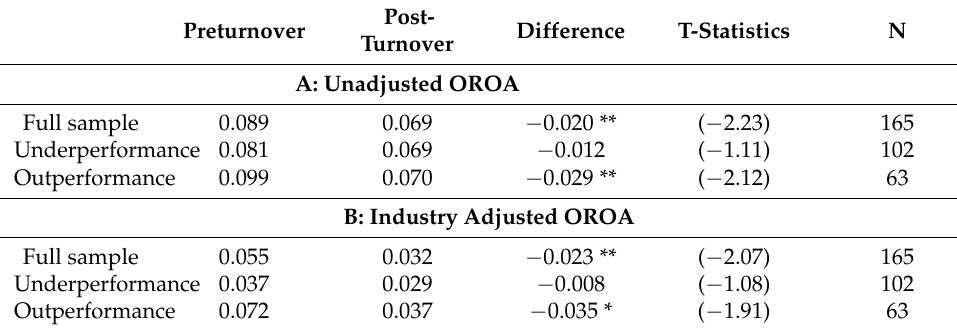
Table 12. Pre- and post-turnover three-year average